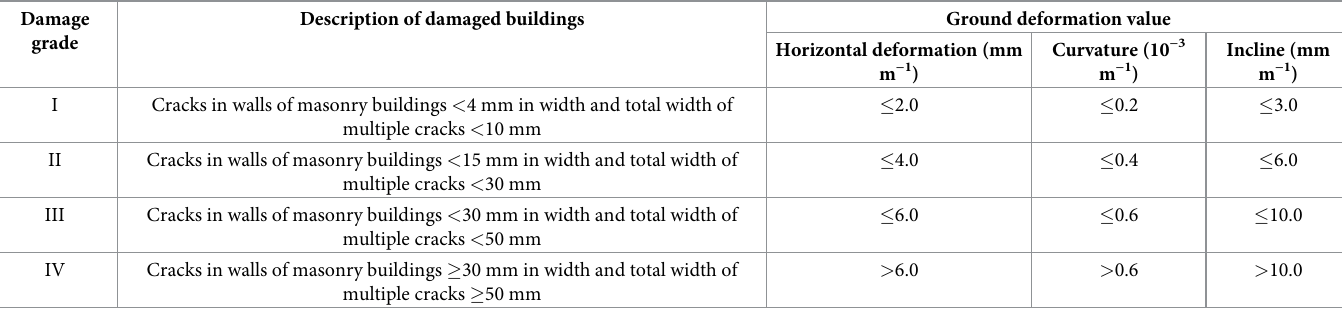
Table 1. Cross-reference table of grade of damage to surface buildings and ground deformation. Damage